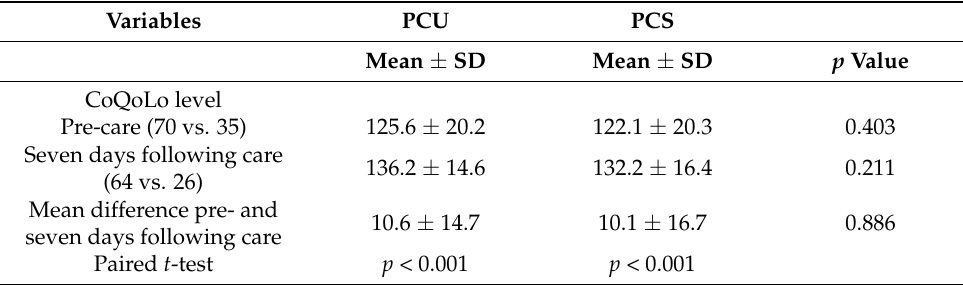
Table 2. CoQoLo level over time following inpatient hospice palliative care unit (PCU) and palliative consultation service (PCS) among terminally ill cancer